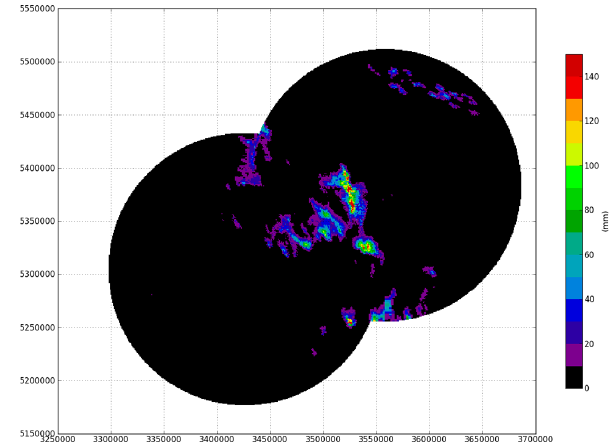
Fig. 4. Composite of a two hours event accumulation of clutter and attenuation corrected data for 2 June 2008, 16:00–18:00UTC, in- cluding the German Weather Service’s C-band radars Tuerkheim and Feldberg (5min scan interval, 1 ◦ angular resolution, 128km range, and 1km range resolution). This event caused a disastrous flash flood in the central map region. Get details about the underly- ing code at http://wradlib.bitbucket.org/recipes.html. For two hours of data, the complete workflow takes about 20s of computation time (on a 32bit Windows machine, using one out of eight threads of an Intel 2.93GHz Quad-Core